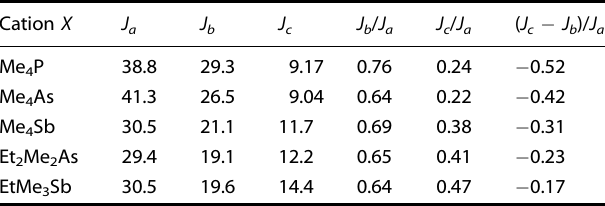
J n representes the effective coupling between the nearest neighbor sites along n direction. The unit of J n is meV. J b / J a , J c / J a , and ( J c − J b )/ J a are also